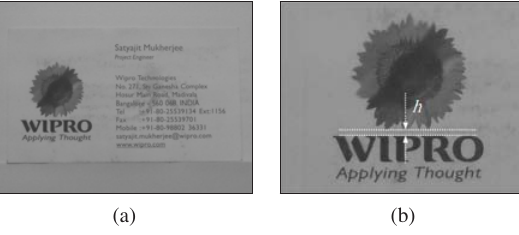
Figure 1. Shortest vertical distance ( h ) between a text region and a non-text